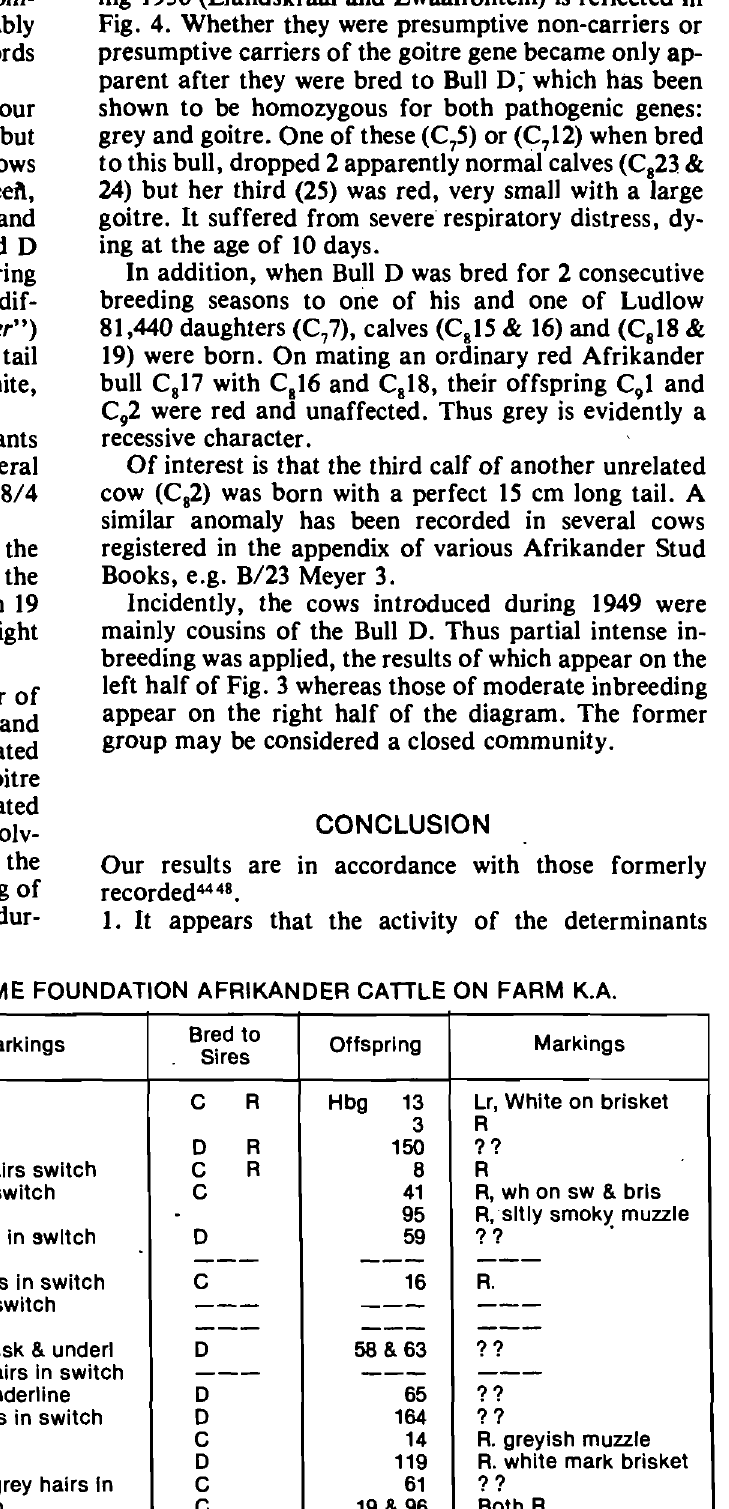
Table 1: MARKING OF HAIRCOAT OF SOME FOUNDATION AFRIKANDER CATILE ON FARM K.A. Cows Bred to Offspring Markings Bred to